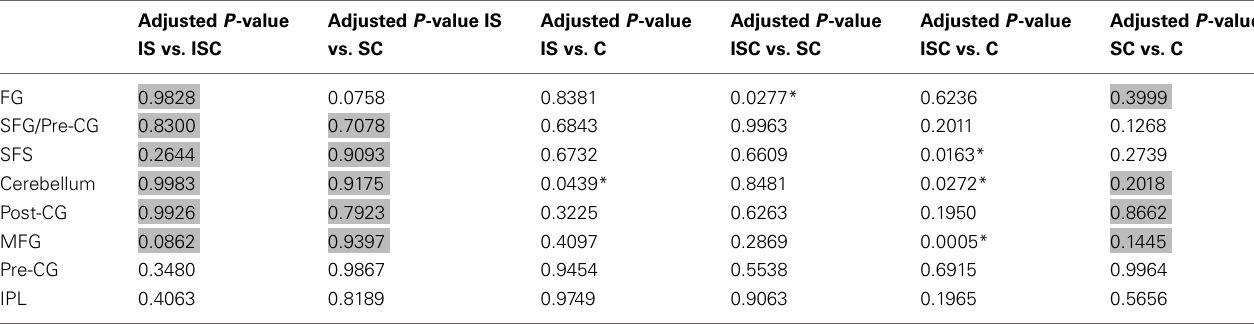
Table 4 | Scheffé corrected p -values for the pairwise comparisons of all experimental conditions for each